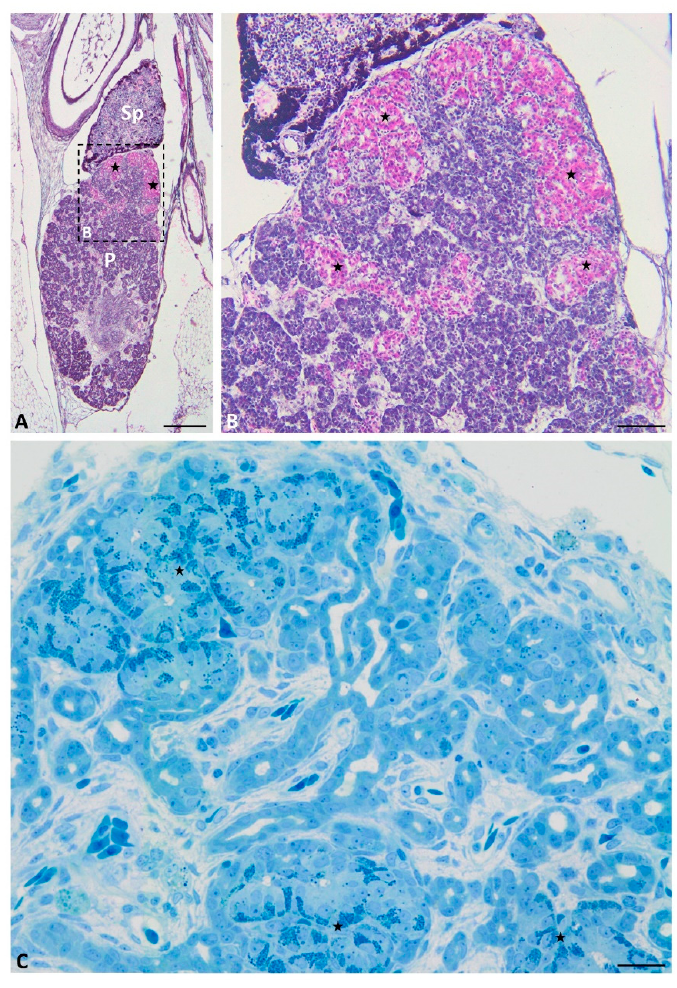
Figure 4. Longitudinal sections through the pancreas of the grass snake embryos at developmental stages IX–XI stained with phloxine and gallocyanin ( A , B ) and methylene blue ( C ). ( A , B ) note large pancreatic islets in the cephalic part of the dorsal pancreas. ( A ) Scale bar = 200 µ m. ( B ) Scale bar = 50 µ m. ( C ) Scale bar = 50 µ m. Abbreviations: P: pancreas; Sp: spleen; asterisk— pancreatic